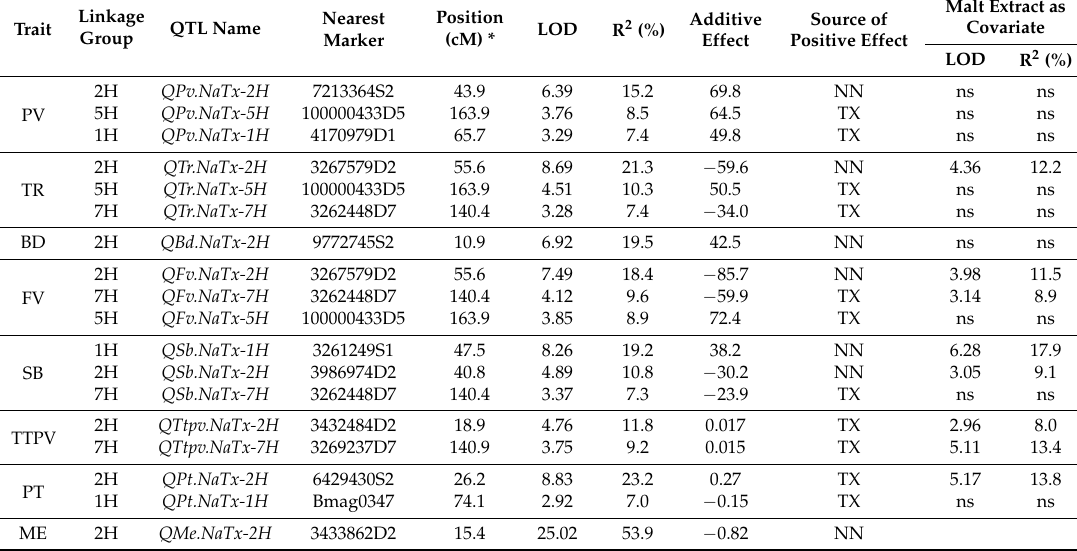
Table 3. Quantitative trait loci (QTL) for pasting properties and malt extract (ME) in the DH population of Naso Nijo × TX9425 based on average data from four different